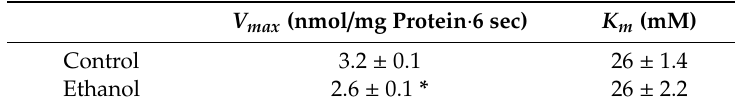
Table 1. The effect of moderate ethanol on the kinetic parameters of sodium-dependent glutamine co-transport in SD rats. Sodium-dependent glutamine uptake was conducted using varying concentrations of glutamine with or without a sodium-free condition in BBMVs isolated from rats treated with moderate ethanol or water (control) for one-hour. Uptakes were conducted over six seconds. The maximal rate of uptake ( V max ) of sodium-dependent glutamine co-transport was significantly reduced when exposed to one-hour of ethanol (* p < 0.01, n = 4). There was no significant change in K m ( p > 0.05, n = 4).